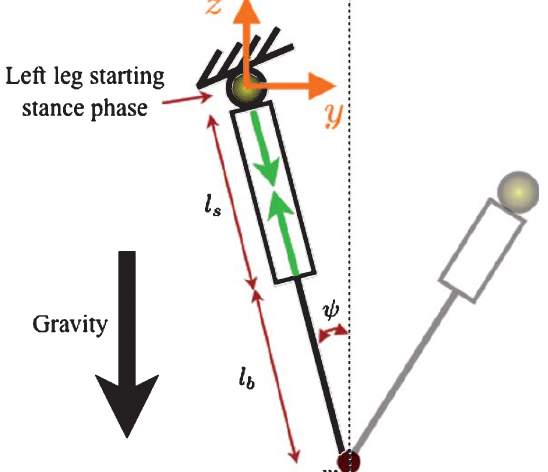
Fig.2. Thebeginningoftheworld-switchedclimber’sleftlegstance phase. Sprawl angle is set, in this case, with respect to gravity. At the beginning of each side, irrespective of the former stance leg’s angular position. lateral forces, and the larger the sprawl angle, the larger the magnitude of those lateral